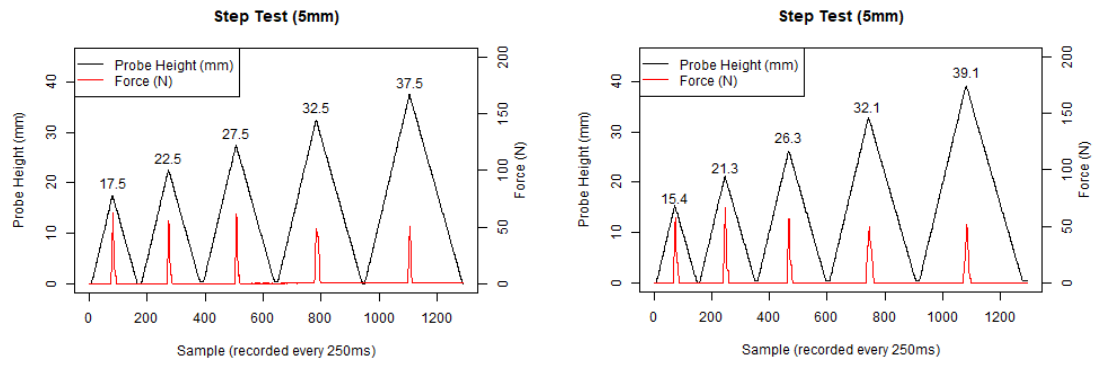
Figure 9. Step benchmarking tests.